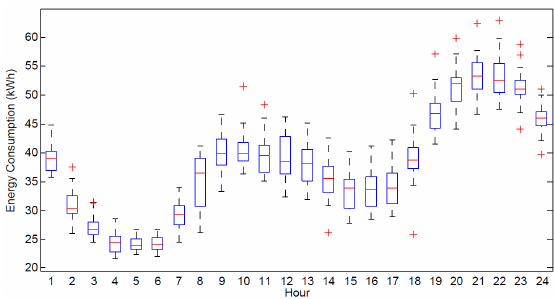
Figure 8. Hourly distribution of energy consumption data for complete